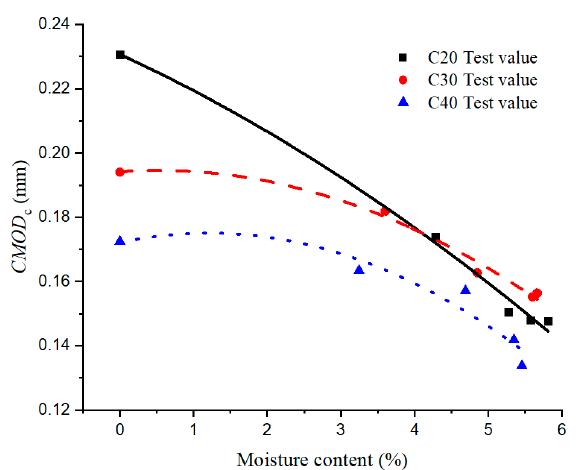
Figure 7. The critical fracture opening displacement CMOD C varies with moisture content.